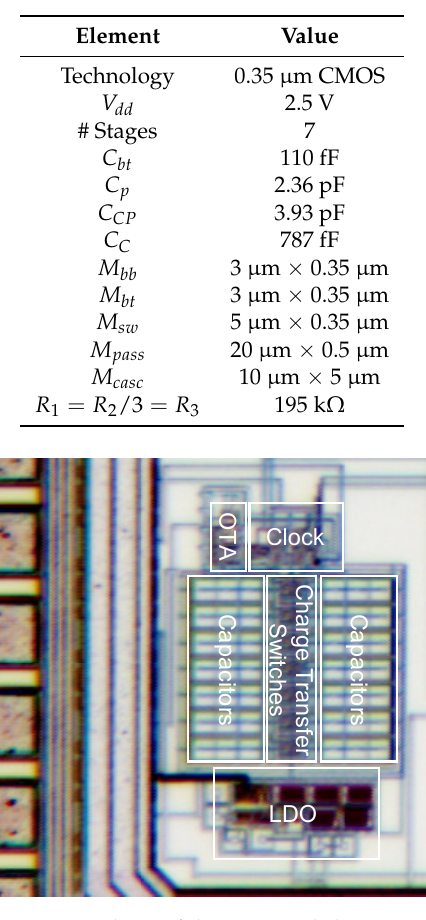
Table 1. Charge pump specifications.